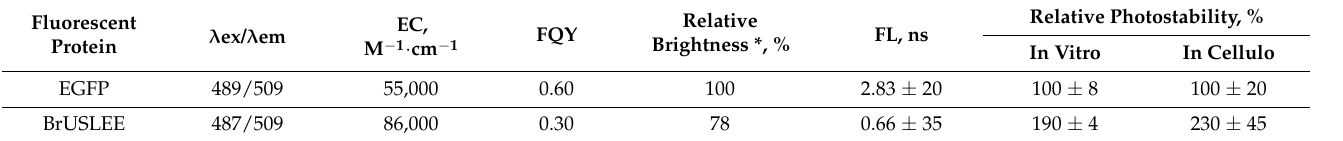
Table 1. Spectral properties of BrUSLEE [10].